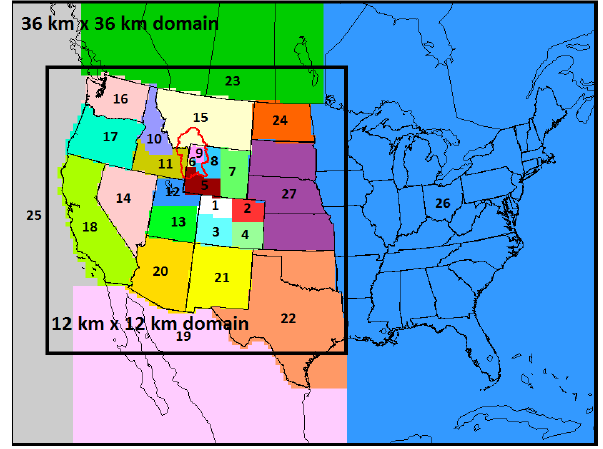
Figure 1. Source region partition for CAMx PSAT simulation in this study. The 27 tagged regions are (1) NW Colorado; (2) NE Colorado; (3) SE Colorado; (4) SW Colorado; (5) Upper Green River, Wyoming; (6) Jackson, Wyoming; (7) eastern Wyoming; (8) western Wyoming; (9) Yellowstone; (10) northern Idaho; (11) Snake River valley, Idaho; (12) northern Utah; (13) south- ern Utah; (14) Nevada; (15) Montana; (16) Washington; (17) Ore- gon; (18) California; (19) Mexico; (20) New Mexico; (21) Arizona; (22) Texas & Oklahoma; (23) Canada; (24) North Dakota; (25) the Pacific; (26) the far east US; and (27) South Dakota, Kansas, and